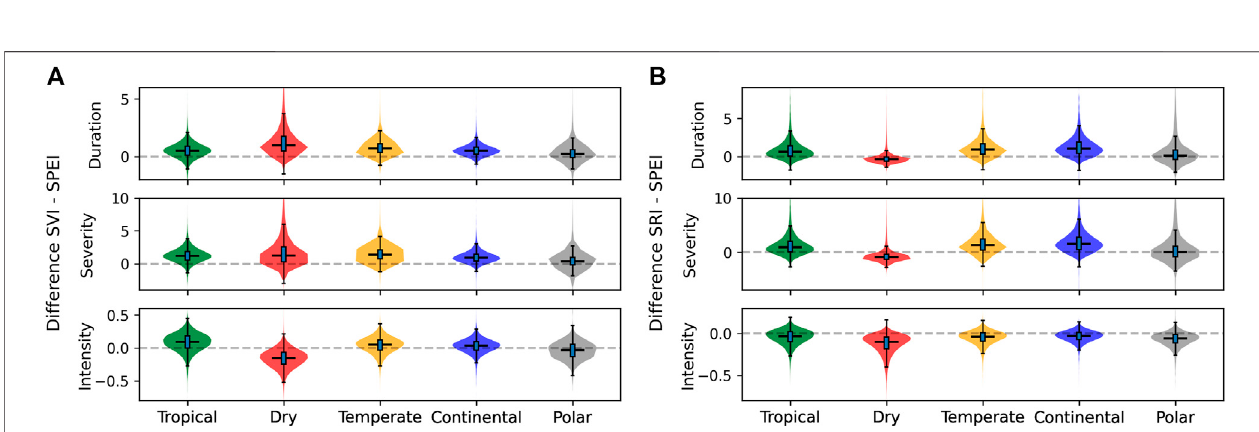
Frontiers in Environmental Science |